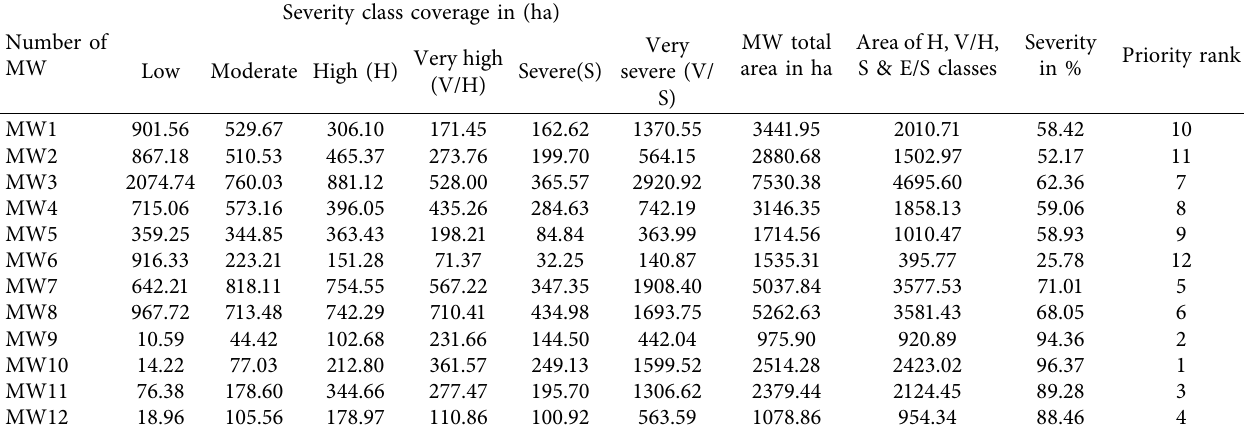
Figure 10: Map of microwatersheds. Table 7: Priority rank of each microwatershed based on the erosion severity